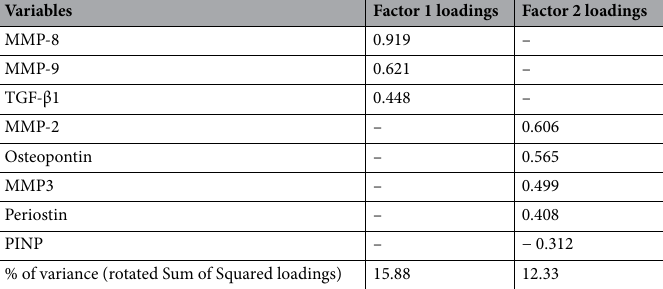
Table 3. The rotated factor matrix for circulating ECM biomarkers using EFA. EFA performed on 10 log- transformed ECM biomarkers. Only factor loadings > 0.3 are presented.